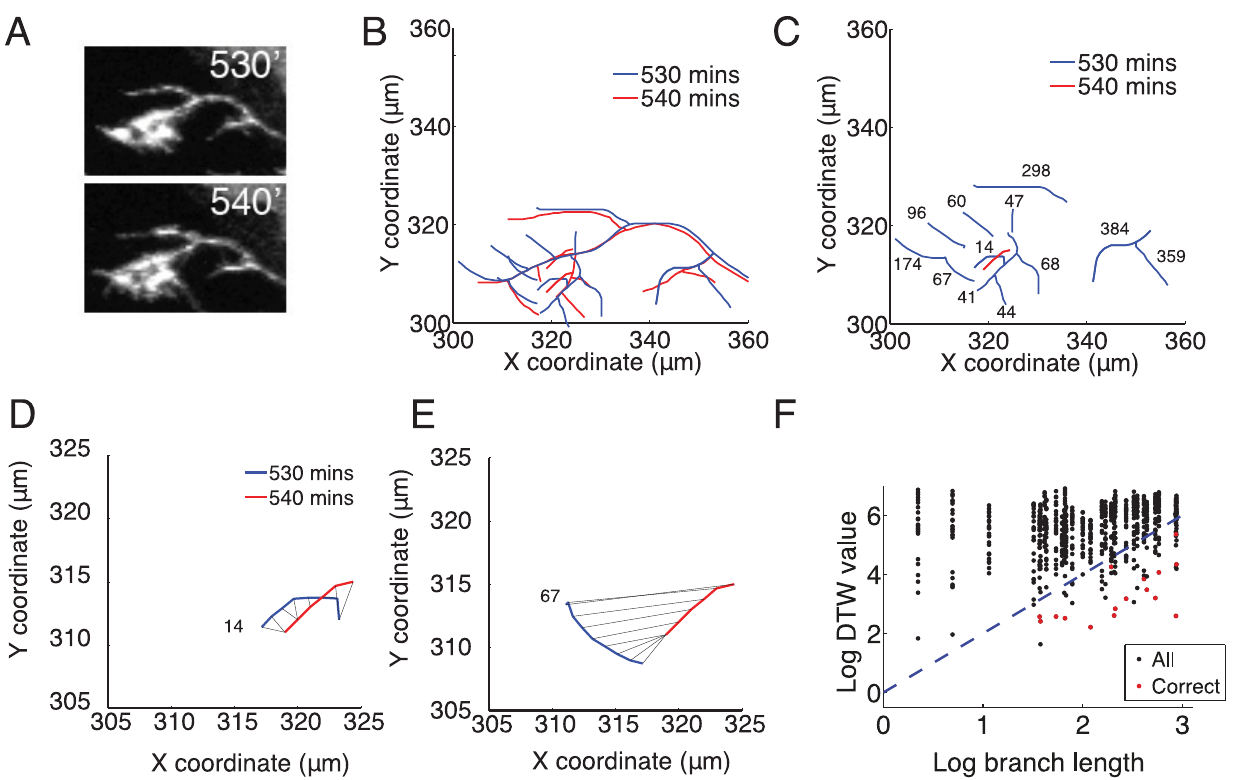
Fig 1. The Dynamic Time Warping (DTW) algorithm matched branches between frames based on location and length. (A): Stills froma time-lapse video at 530 and 540 minutes. Brn3C+ RGC axons were genetically sparsely labelled with mGFP. (B): Overlapped axon tracings at 530 ’ (blue) and 540 ’ (red). (C): Comparison of branches from 530 ’ (blue) to one branch from the 540 ’ frame (red). For clarity, the primary axon shafts are not shown. The number next to each blue branch is the DTW cost between it and the one red branch. Branches that are likely to be the same between two consecutive traced frames have the smallest DTW distance values. (D): DTW joins coordinates on the two branches (black lines) and assigns the lowest value (14) to the warping path, suggesting a correctly matched branch. This was confirmed by visual assessment of the tracings. (E): DTW comparison between the selected branch from 540 ’ and a branch further away gives a higher DTW value (67). (F): The log of the DTW distance between pairs of branches near the end of the time-lapse movie (1700 ’ and 1710 ’ ) versus the log of the length of the branches. The length of several branches could be similar, resulting in columns of matches that nearly overlap. The red points indicate correct matches as determined by visual inspection. The blue dotted line gives the maximum value for an acceptable branch match between consecutive frames, DTW = Length 2 , (the length of the branch in the first frame). This was included as a threshold for the automated matching of branches, and improved the reliability of the DTW algorithm. The branches with no corresponding red dot were correctly identified (compared to visual inspection) as having no match (deleted).